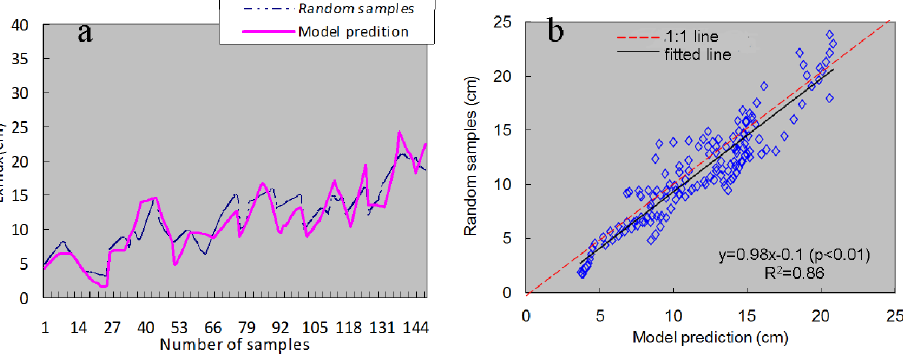
Figure 12. Error analysis of model prediction: ( a ) random samples versus model prediction ( n = 147); ( b ) linear relationship between model prediction and random samples (RMSE = 4.7) ( n = 147).